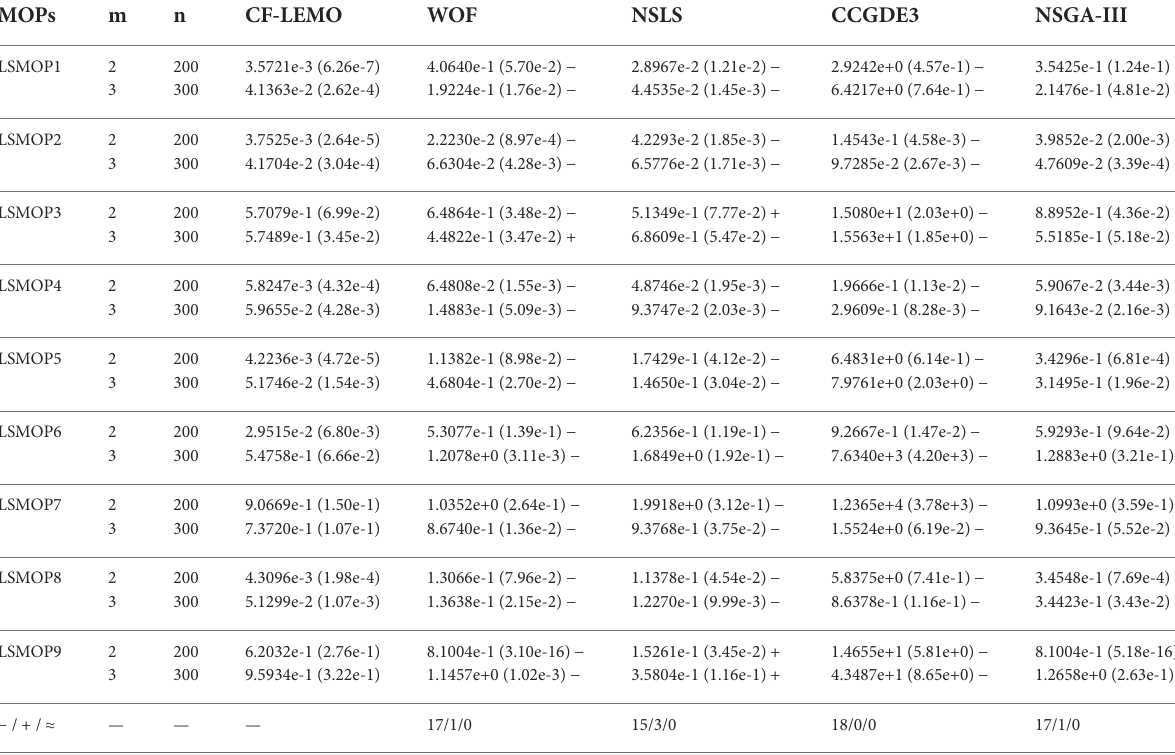
TABLE 1 IGDvaluesofthefivealgorithmsonbenchmarksLSMOP1-LSMOP9with2-and3-objectives. MOPs